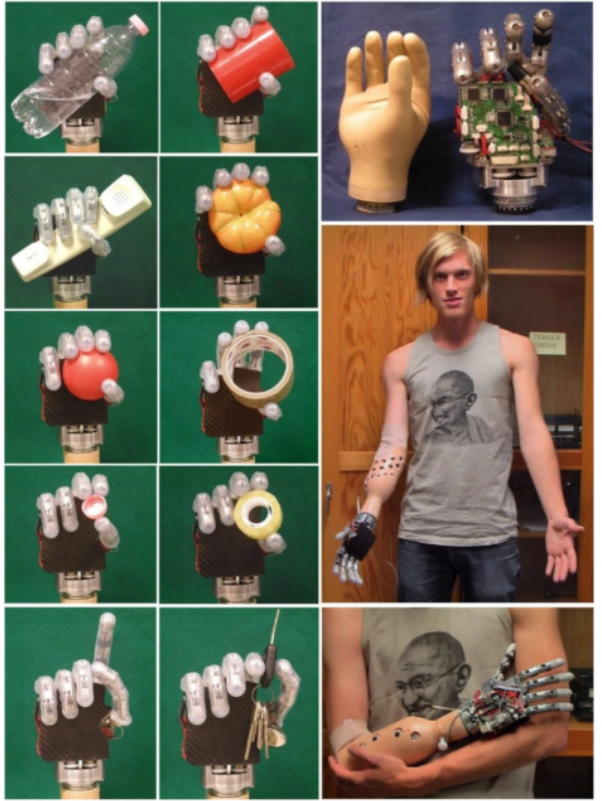
Figure 3. Functional grasping and outlook of the SmartHand developed by the ARTS Lab at Scuola Superiore Sant’Anna, Pisa, Italy. Reprinted with permission from